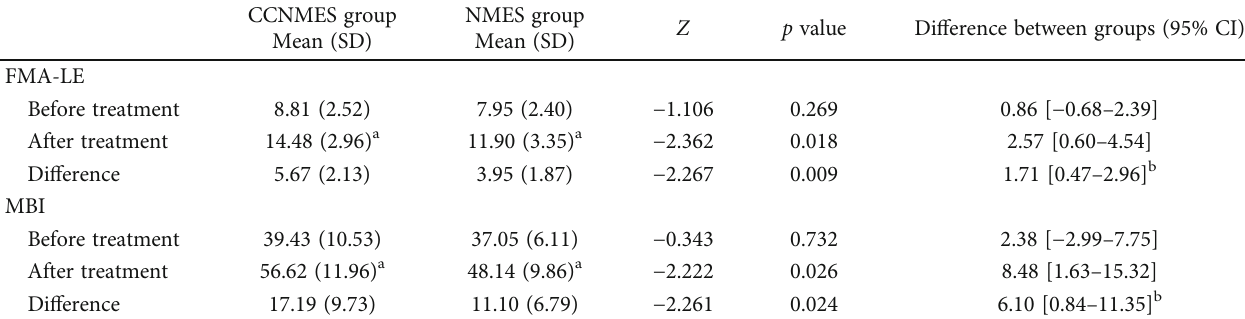
Table 2: Comparison of motor performance and ADL in two groups and at before and after